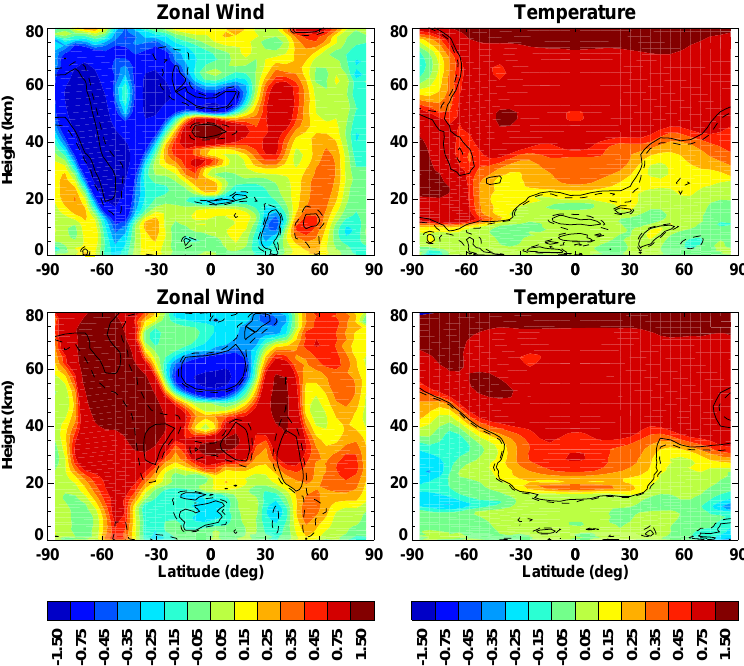
Fig. 19. Latitude-altitude dependence of the annual mean regression coefficient for the solar variability only ensemble mean (top) and for the combined solar variability and EPP ensemble mean (bottom): zonal wind (left, ms − 1 per 100 units of F10.7) and zonal mean temperature (right, K per 100 units of F10.7).